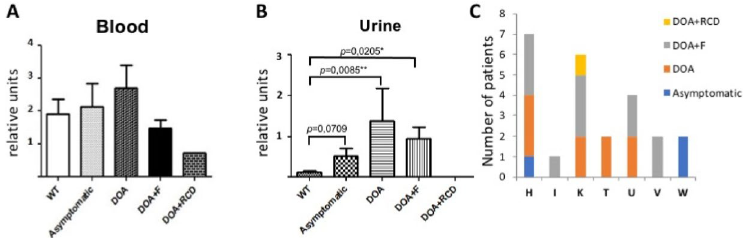
Figure 6. mtDNA quantification in blood ( A ) and urine ( B ) from controls (WT) and SSBP1 individuals with the different ocular phenotypes. ( C ) Distribution of the SSBP1 individuals with the different ocular phenotypes, according to their